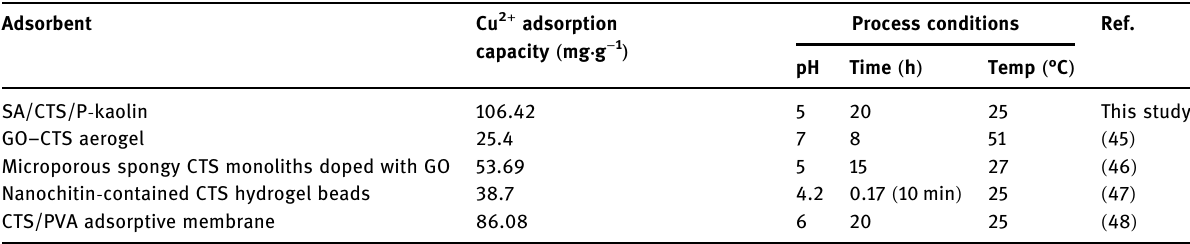
Table 4: Comparison of the properties of common adsorbents and the products in this study; all adsorbents followed the Langmuir isotherm and pseudo - second - order kinetics